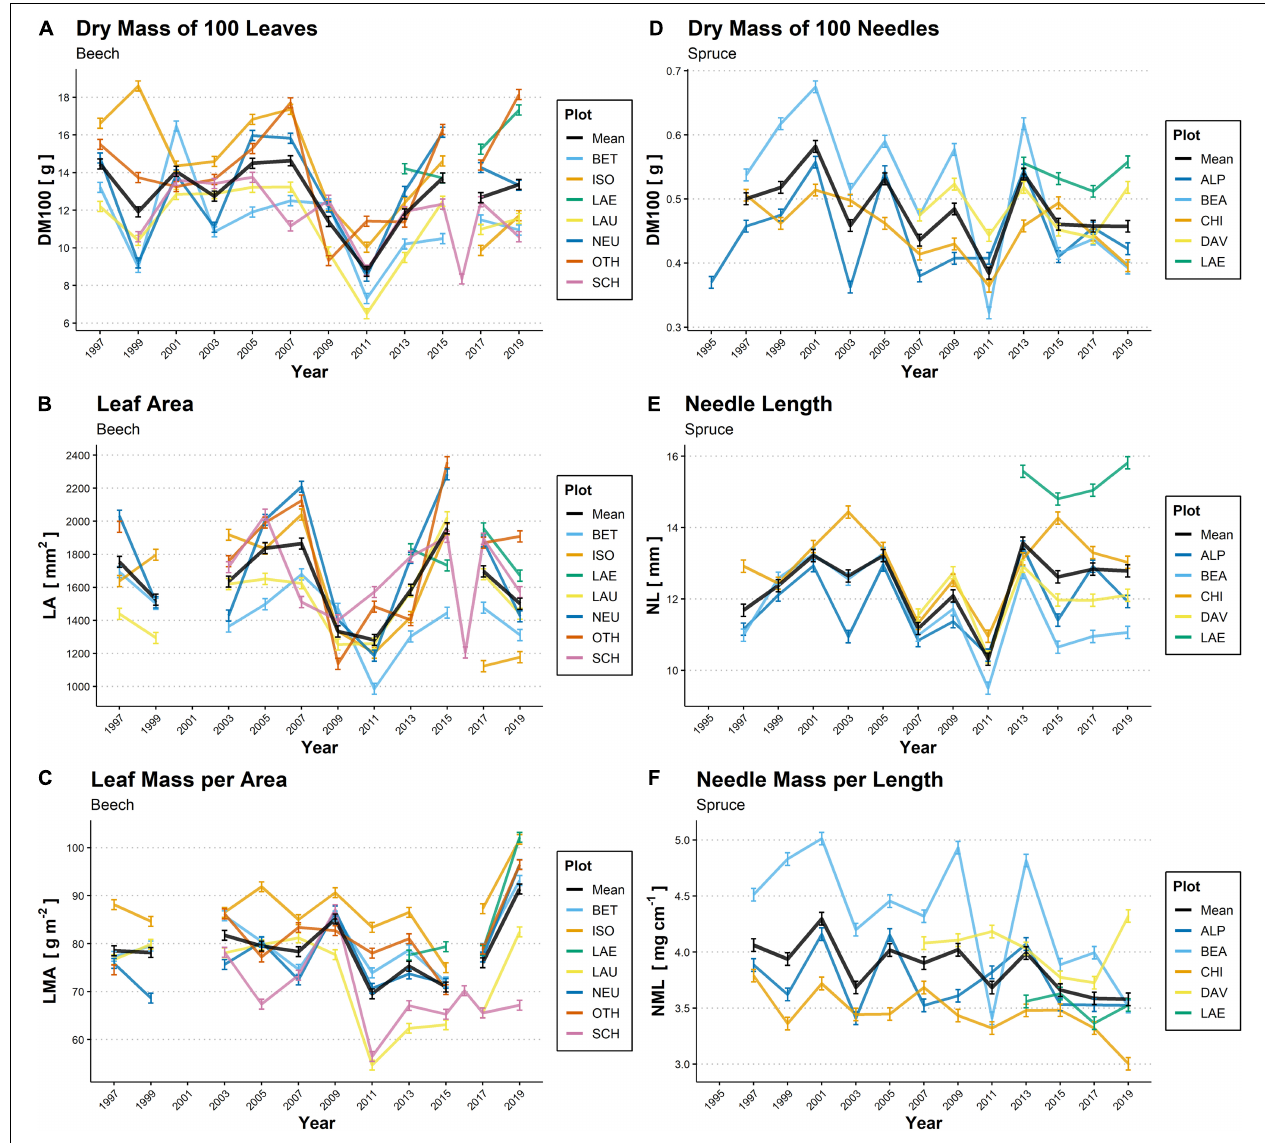
FIGURE 2 | Biennial temporal variations in the dry mass of 100 leaves (DM100; A,D ), leaf area (LA; B ) and needle length (NL; E ), leaf mass per area (LMA; C ) and needle mass per length (NML; F ) of beech leaves ( A–C ; 1997–2019) and spruce needles ( D–F ; 1995–2019) in 11 plots across Switzerland. The colored lines denote individual plots, while the solid black line indicates the mean from all plots. For beech, no samples were available for LA measurement in 2001, and exceptional values were measured in 2016 in SCH. For spruce, continuous observations in DAV and LAE first started in 2007 and 2013, respectively. For plot codes see Table 1 . Mean values ± SE are shown ( n =